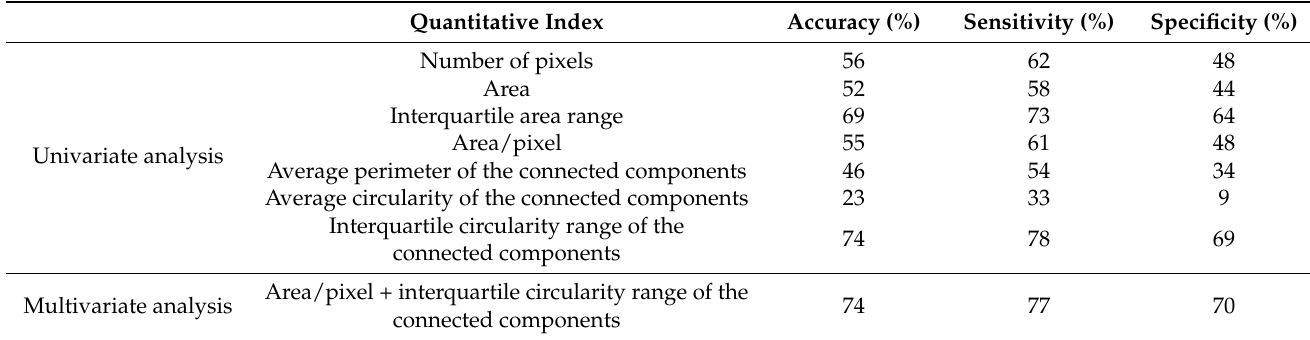
Table 3. Univariate and multivariate analysis